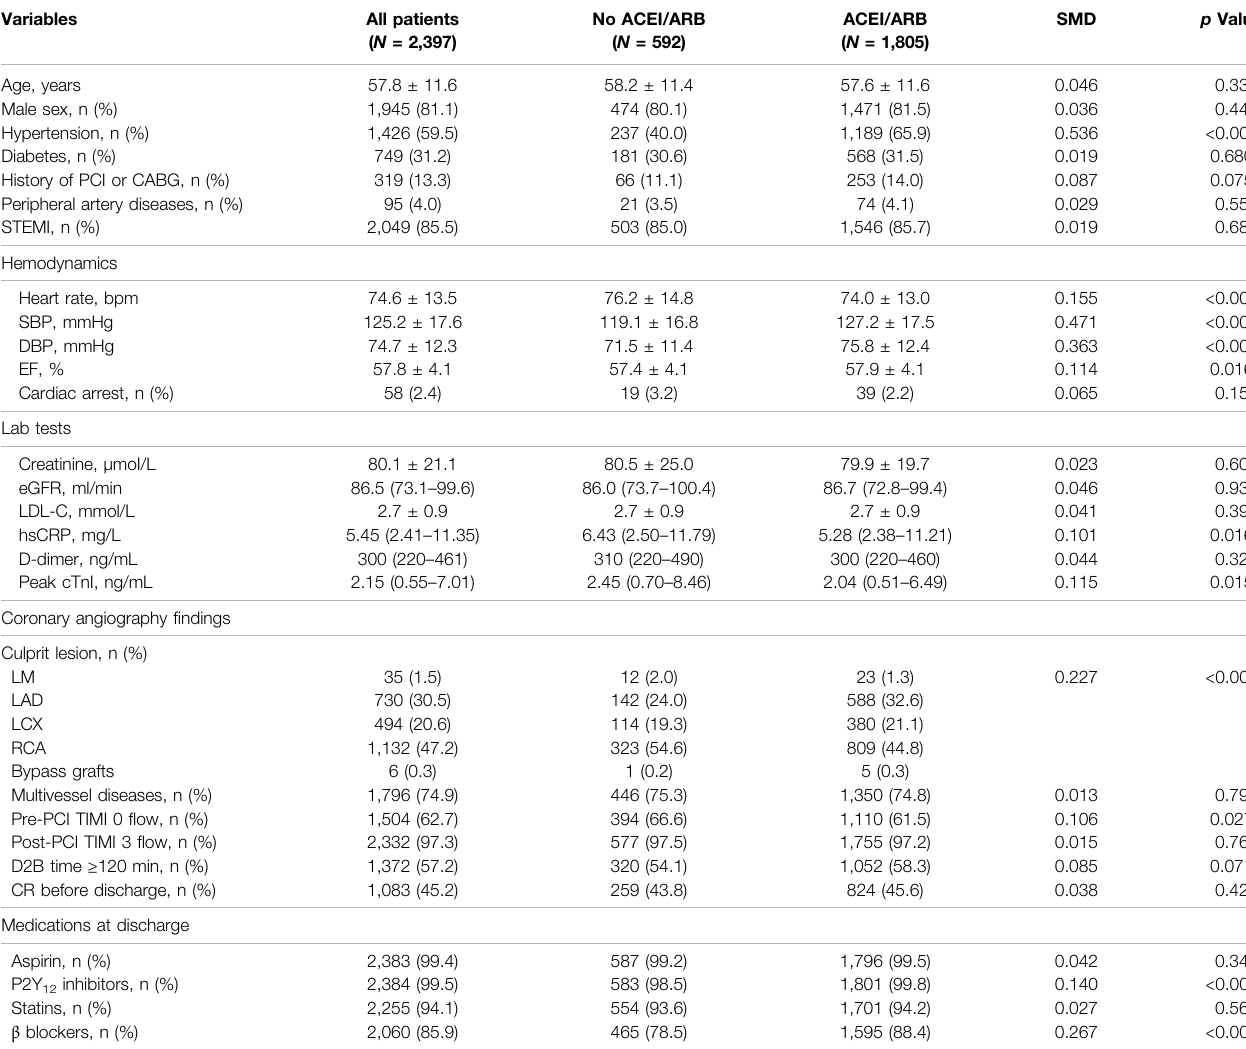
TABLE 1 | Baseline characteristics of patients in the original dataset strati fi ed by ACEI/ARB medication. Variables All patients ( N = 2,397)